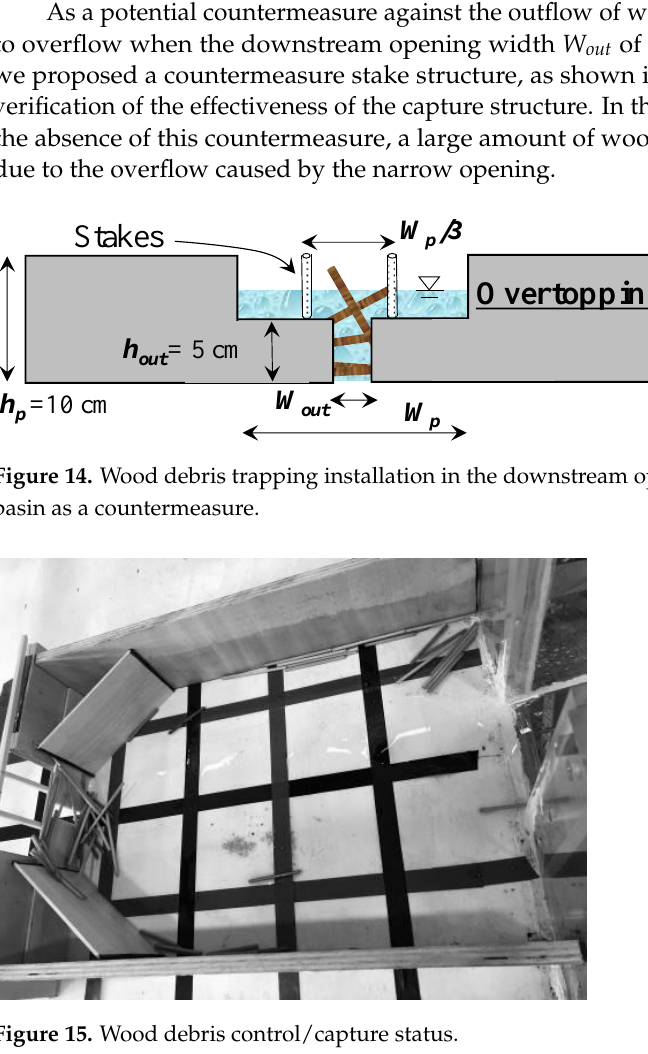
Figure 13. Outline of the experiment.